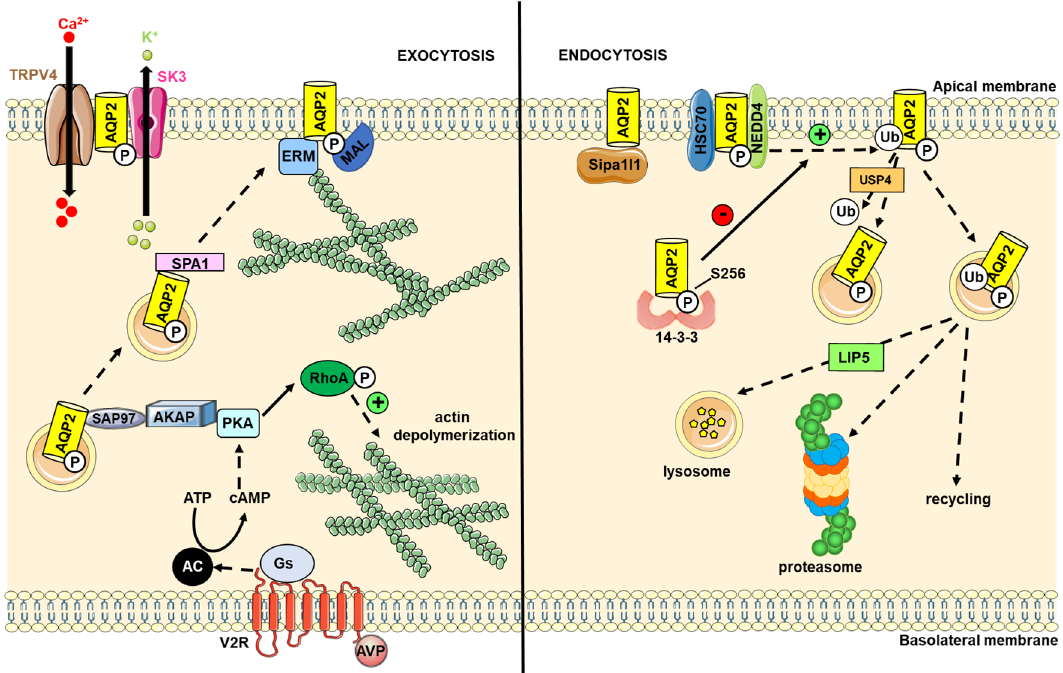
Figure 4. Role of the protein–protein interaction involving AQP2 in kidney collecting duct cells. Upon AVP stimulation, leading to subsequent cAMP increase and PKA activation, AQP2 moves to the plasma membrane thanks to the help of various protein partners. In the absence of hormonal stimulation, AQP2 endocytosis also requires many protein partners. Due to the high number of pro- teins that bind to AQP2, only some of them are indicated in this figure. 14-3-3: protein 14-3-3-; AC: adenylyl cyclase; AKAP: A-kinase-anchoring protein; AVP: arginine vasopressin; cAMP: cyclic adenosine monophosphate; ERM: ezrin/radixin/moesin protein family; Gs: protein Gs; HSC70: heat shock protein 71 kDa protein; LIP5: lysosomal trafficking regulator-interacting protein 5; MAL: my- elin and lymphocyte-associated protein; NEDD4: E3 ubiquitin protein ligase NEDD4; PKA: protein kinase A; PKC: protein kinase C; RhoA: small GTP-Binding Protein RhoA; SAP97: synapse-associ- ated protein 97; Sipa1l1: signal-induced proliferation-associated 1 like 1; SPA1: signal-induced pro- liferation-associated gene-1; SK3: small-conductance potassium channel; TRPV4: Transient Recep- tor Potential Cation Channel Subfamily V Member 4: USP4: ubiquitin-specific peptidase 4.